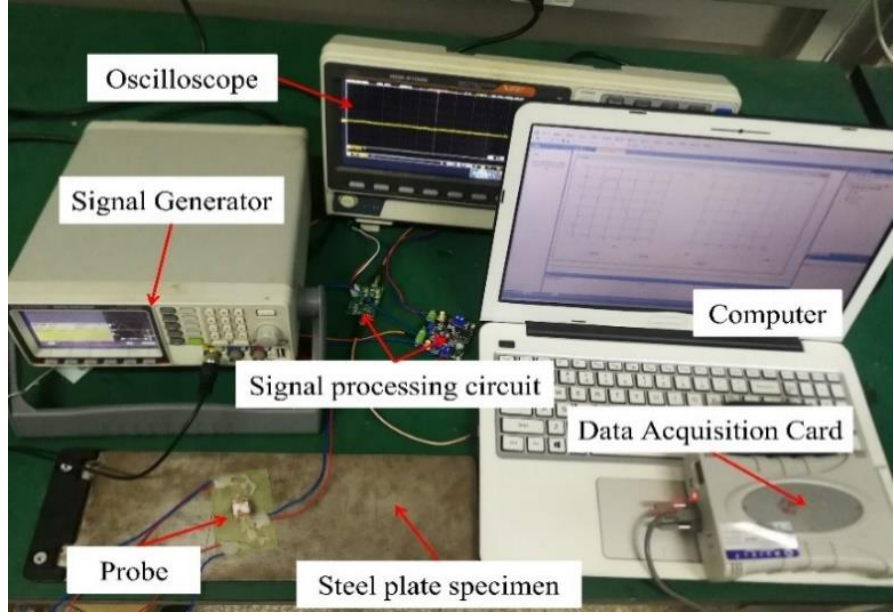
Figure 12. The experimental system.